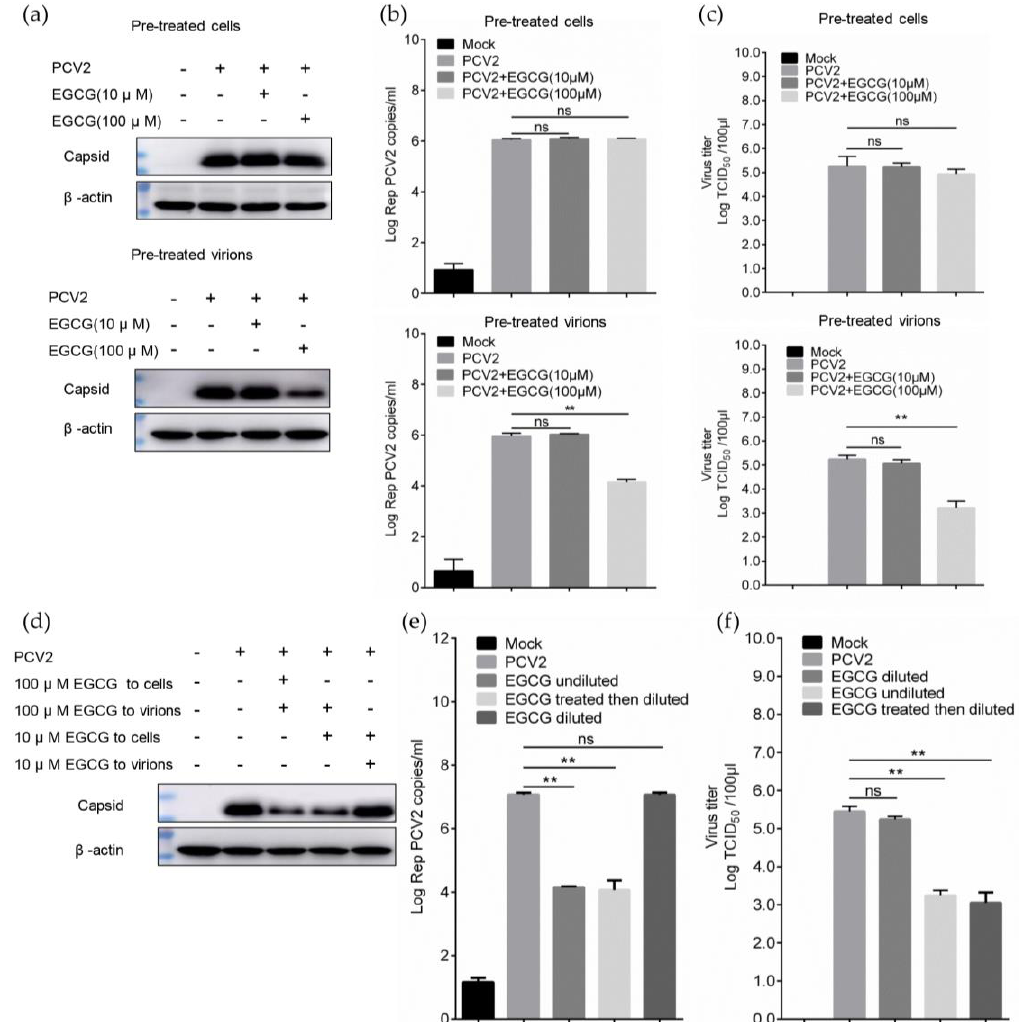
Figure 2. EGCG inhibits the PCV2 infectivity by directly targeting virions. ( a – c ) Cells were pre-exposed to 10 µ M or 100 µ M EGCG for 60 min at 37 ◦ C, then infected with PCV2 at MOI = 1.0 for 1 h, alternatively, virus was pre-mixed with EGCG under the same condition before being added to the cells, then the cells were cultured without EGCG. At 72 hpi PCV2 infectivity was assessed by viral protein expression ( a ), viral genome copies ( b ), and virus titers ( c ). ( d – f ) Virions were pretreated with 100 µ M EGCG and thereafter diluted 10-fold prior to infecting cells, which were cultured without EGCG and tested with immunoblotting ( d ), qPCR ( e ), and virus titers determination ( f ). Three independent experiments were performed and the results were compared using Student’s t -test (n.s., not significant; ** p <